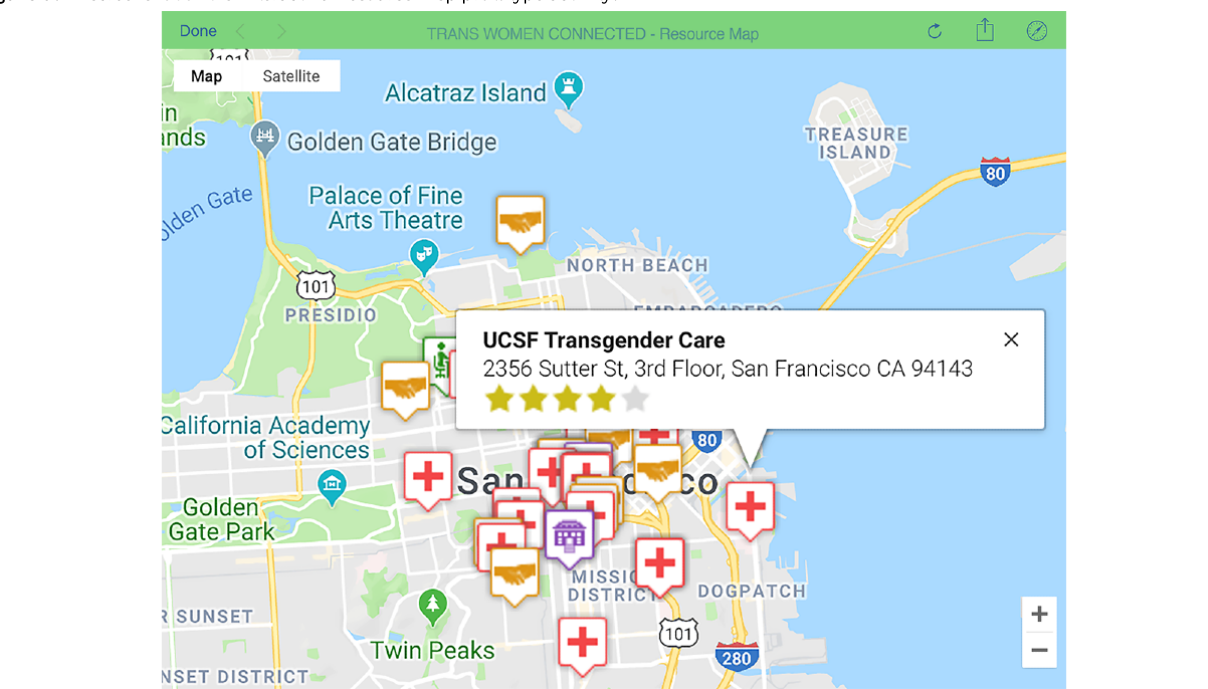
Figure 6. A screenshot of the Interactive Resource Map prototype